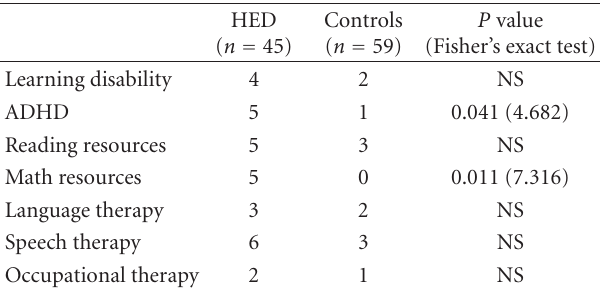
Table 2: Previous diagnosis of ADHD and/or learning disability, and educational resources for children with HED and control group.